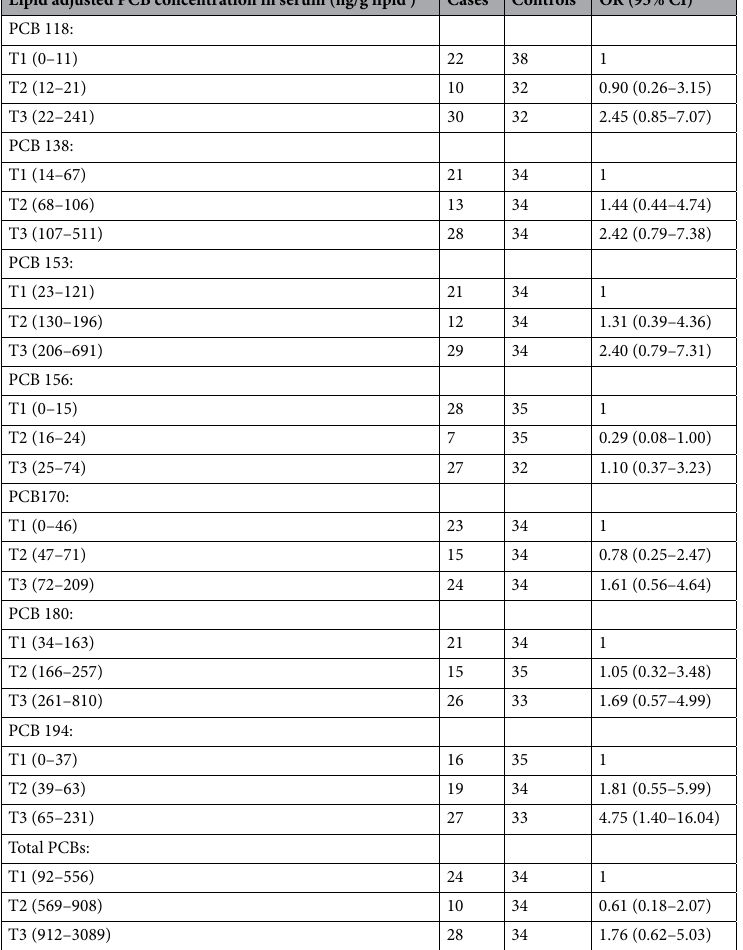
Table 4. Odds ratios (ORs) for hepatocellular carcinoma (HCC) according to distribution tertiles of polychlorinated biphenyls (PCBs) in the controls. *Adjusted for age, sex, residence, education and presence of one or more risk factors for HCC by logistic regression analysis.